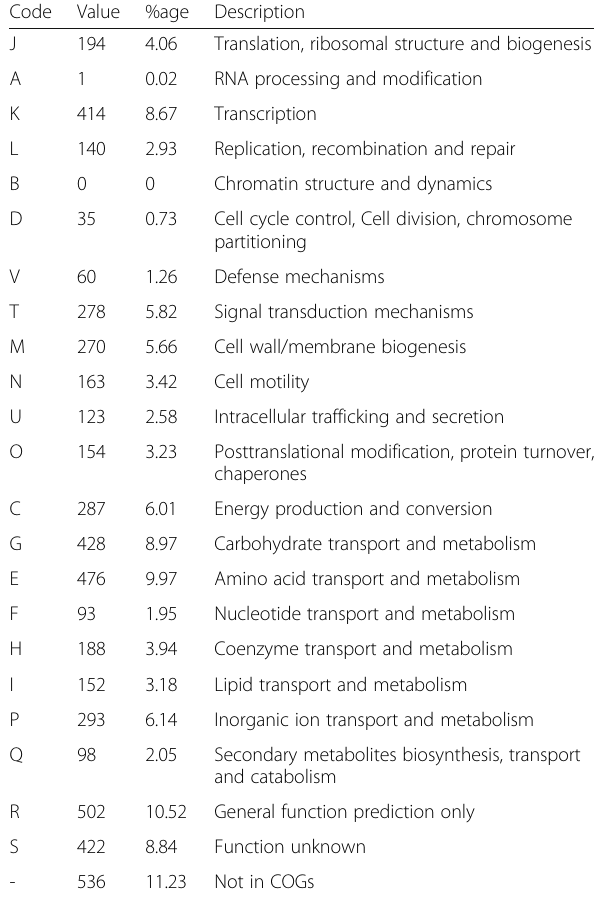
Table 4 Number of genes associated with general COG functional